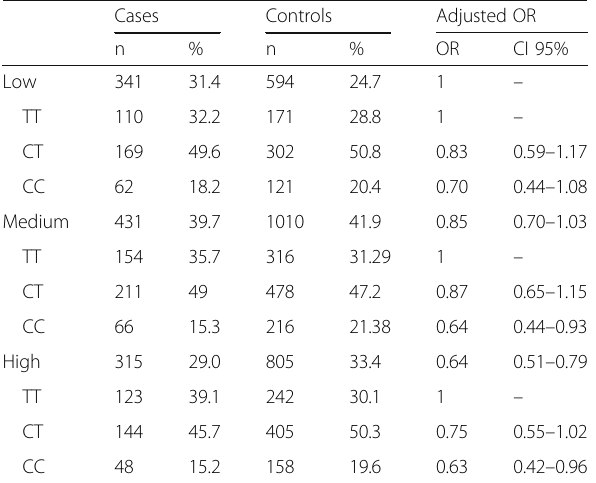
Table 3 Association between SNP rs4939827 and the Mediterranean dietary pattern adherence in relation with colorectal cancer taking into account the genotype Cases